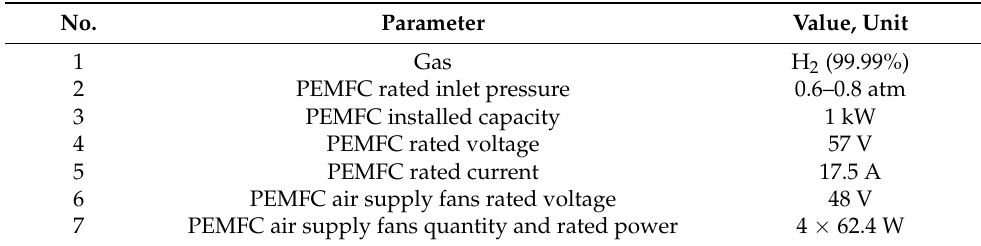
Figure 5. Appearance of the fuel cell test bench.